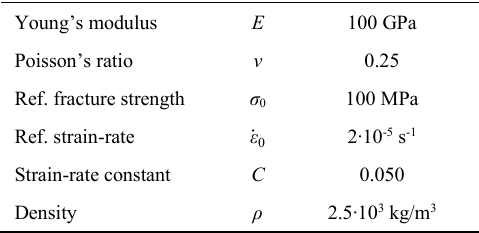
Table 2: Material properties used for the unit element test.